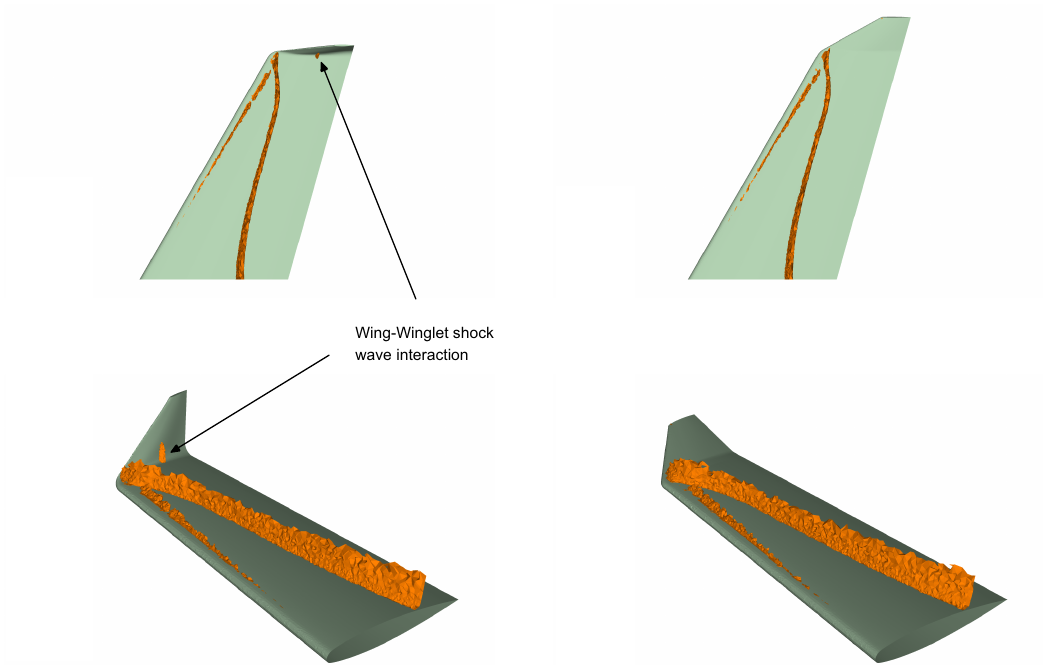
Figure 15. Shock wave system for AOA 2 ◦ and two different values of winglet’s cant angle. The shock wave region was computed using the criterion of Lovely and Haimes [32]. The left image corresponds to a winglet cant angle of 80 ◦ and the right image to a cant angle value of 15 ◦